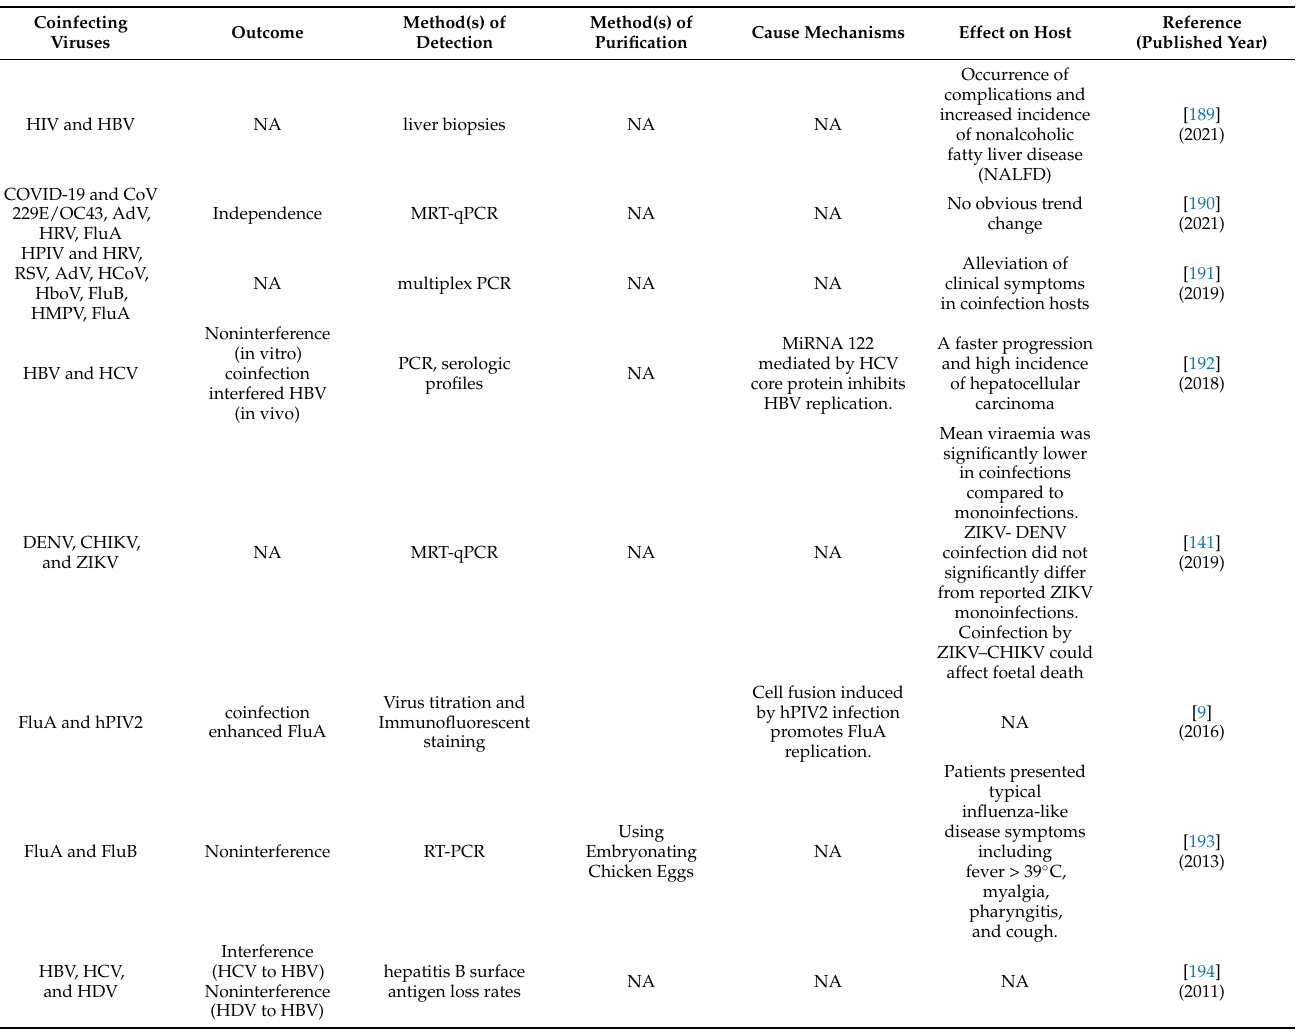
Table 1. Summary of viral coinfection